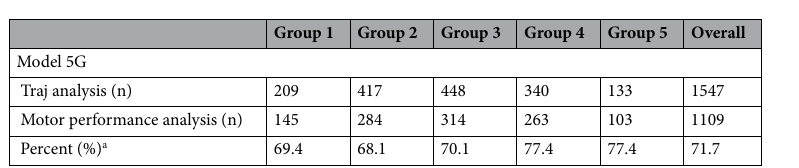
Table 4. Numbers of participants included in our trajectory analysis and our analysis including motor performance. a Indicates how many percent of the participants in each group are included in our regression analysis.